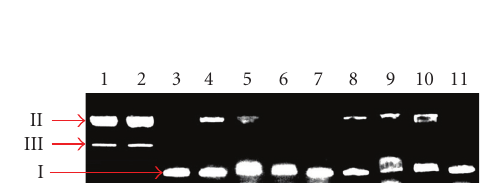
di ff erence Δ , where Δ = ν as (CO 2 ) − ν s (CO 2 ), is 122 cm − 1